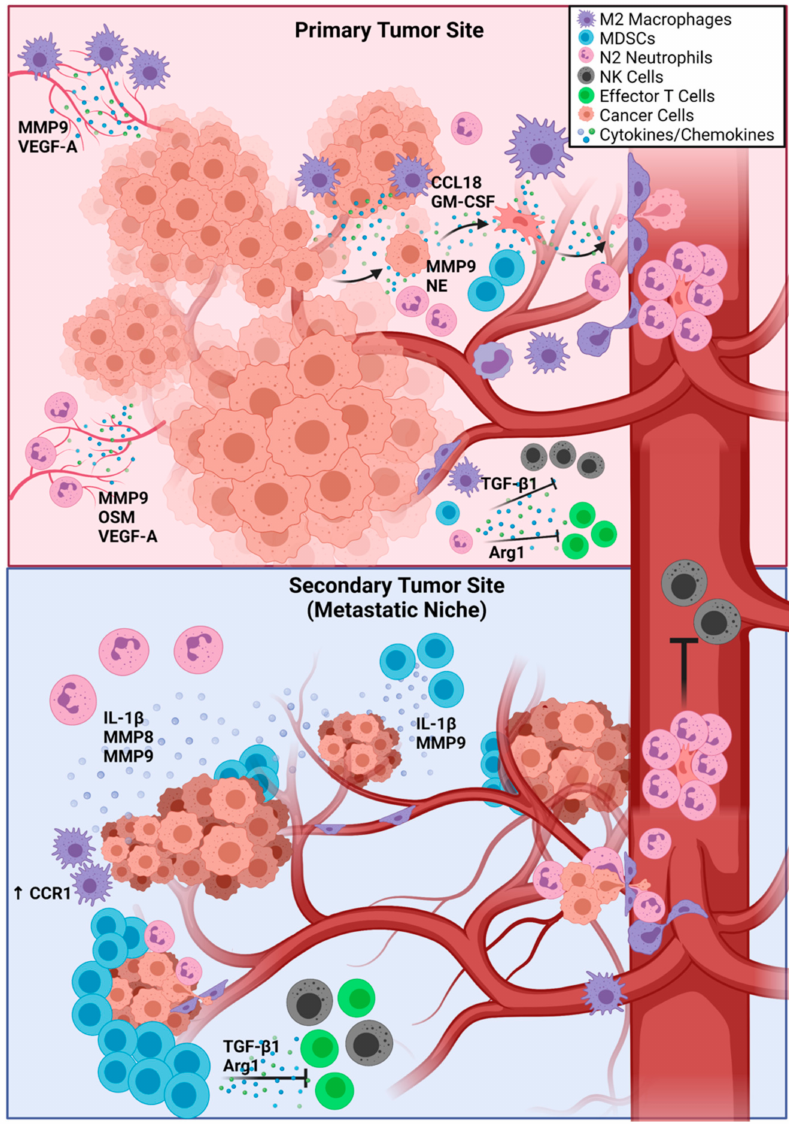
Figure 1. The Influence of Innate Immune Cells on Metastasis. M2 TAMs and N2 TANs drive angiogenesis at the primary tumor via secretion of MMP9, VEGF-A, and OSM. M2 TAMs secrete CCL18 and GM-CSF to drive EMT in tumor cells, while N2 TANs remodel the ECM of tumor cells through secretion of MMP9 and NE. M2 TAMs, N2 TANs, and MDSCs secrete TGF- β 1 and Arg1 to inhibit the functions of NK cells and effector T cells. In the bloodstream, N2 TANs form